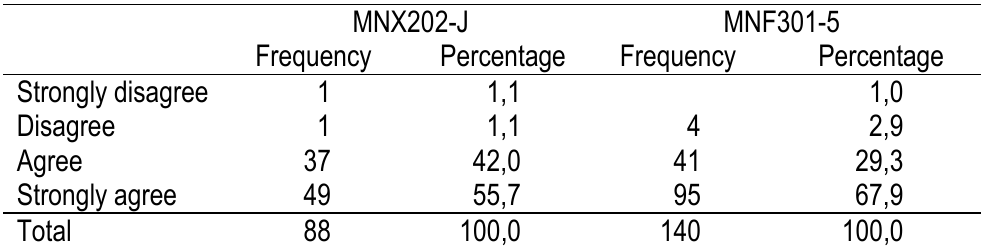
Table A2. Reflects the views of the respondents on the importance of submitting the assignment. Table A2. I thought it was important for me to submit the